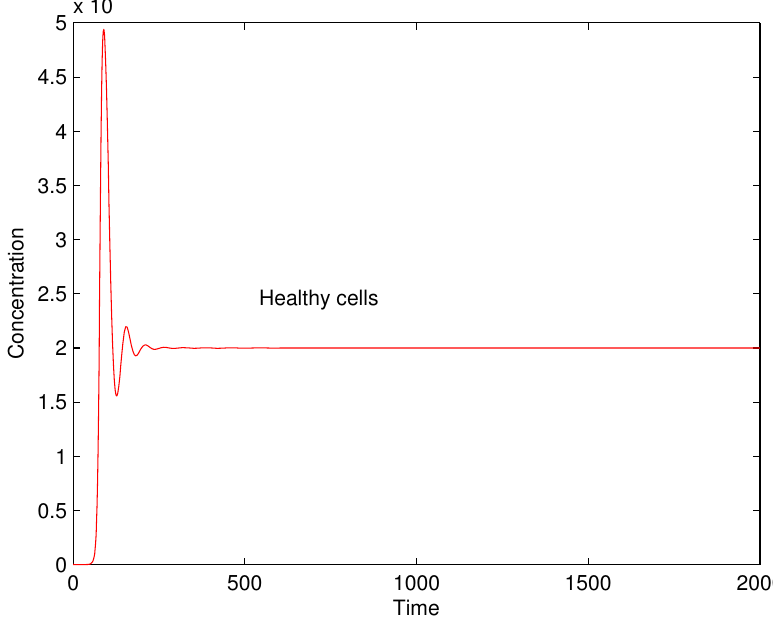
Figure 4. Concentrations of healthy cells for p id =